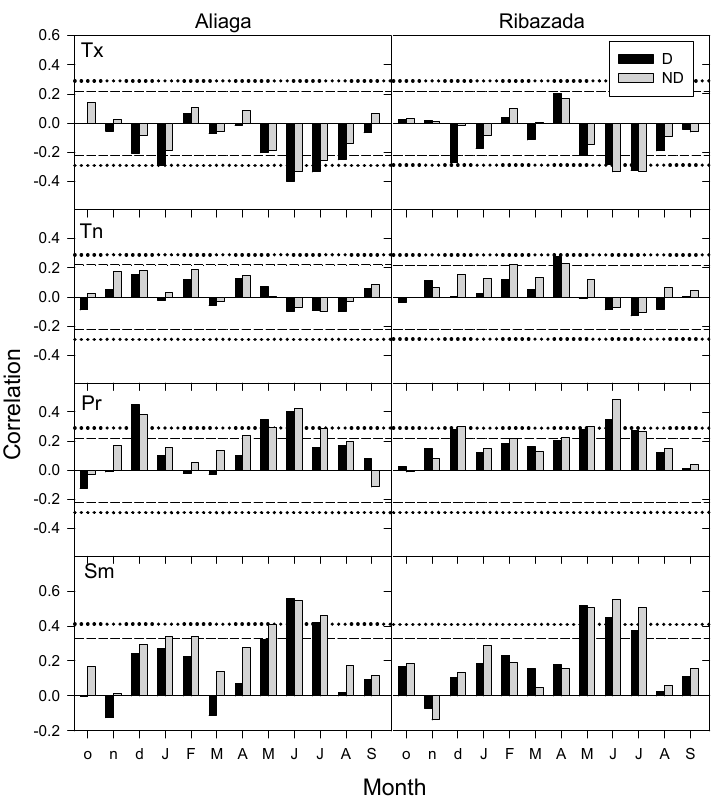
Figure 4. Climate-growth relationships based on Pearson correlations calculated between series of ring-width indices of declining (D) and non-declining (ND) junipers vs. monthly climate variables (Tx, mean maximum temperature; Tn, mean minimum temperature; Pr, precipitation; Sm, soil moisture). Correlations were calculated from previous October to current September with months abbreviated by lowercase and uppercase letters corresponding to the prior and growth years, respectively. Dashed and dotted horizontal lines show the 0.05 and 0.01 significance levels, respectively.